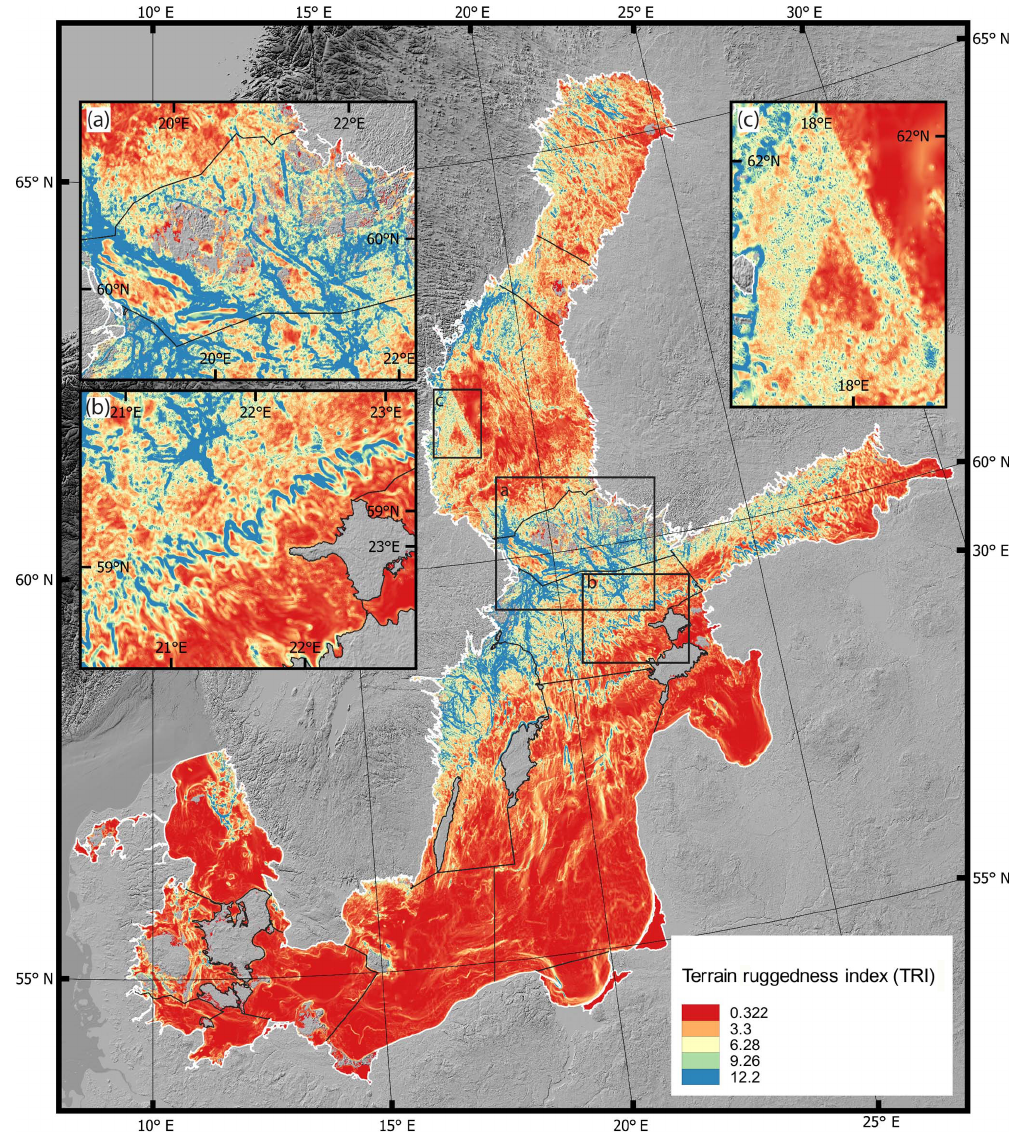
Figure 4. Calculated terrain ruggedness index (TRI) of the Baltic Sea seafloor. Areas specially discussed in the text are shown in the close-up maps (a–c)